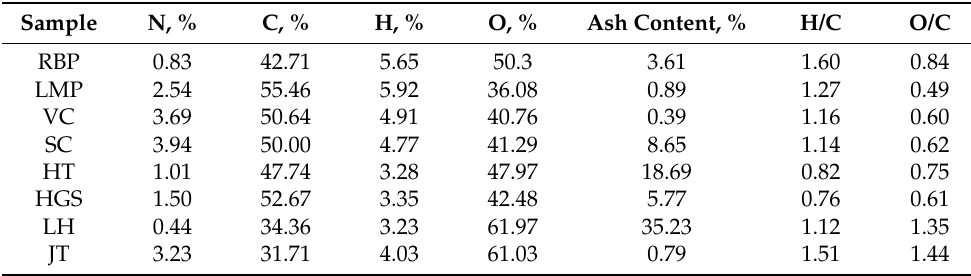
Table 2. Elemental composition and ash content in the samples. (See Table 1 for sample name abbreviation definitions.)